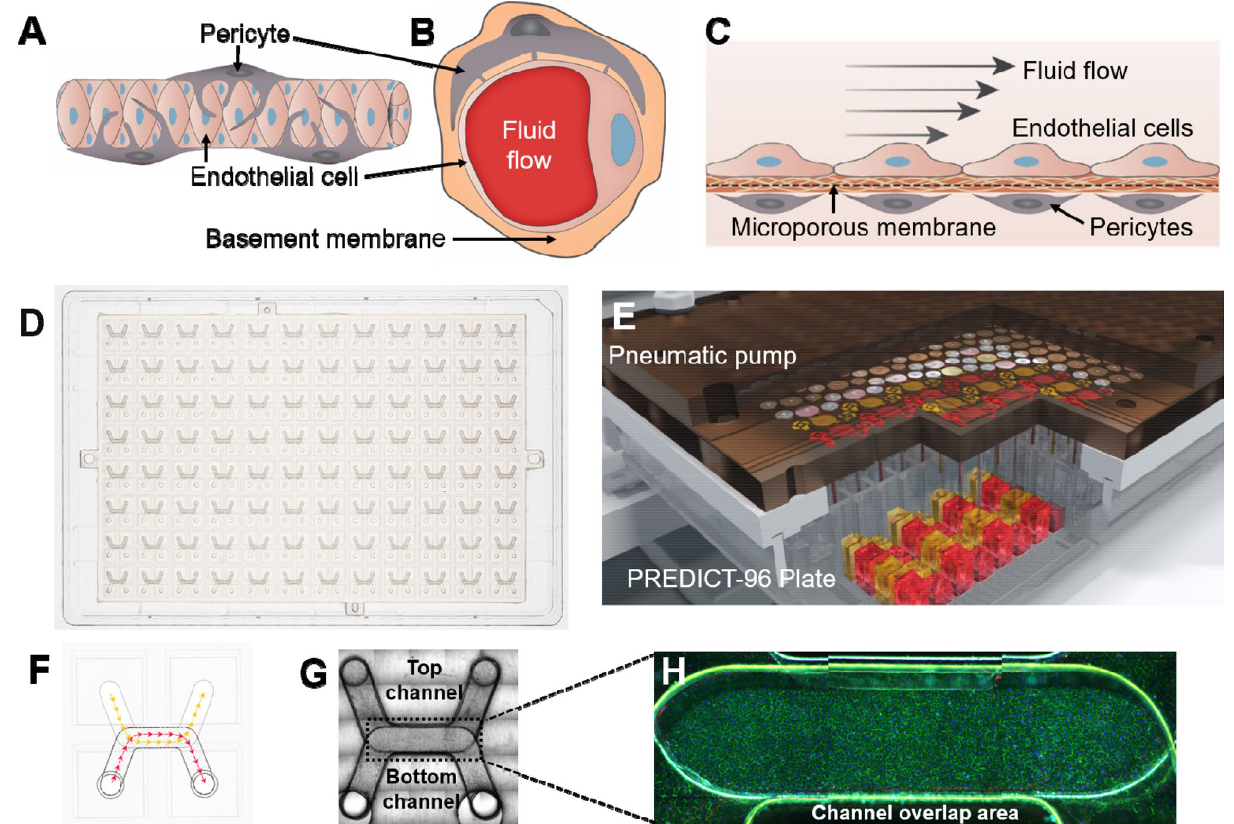
Figure 1. Development of the microfluidic microvascular co-culture model in the PREDICT96 platform. ( A ) Side-view schematic of the microvasculature. Capillaries are surrounded by pericytes which, under healthy conditions, help stabilize and mature the endothelium. ( B ) Cross-section schematic showing interaction of endothelial cells (ECs) and pericytes (PCs) through basement membrane. ( C ) Side-view cross-section schematic of the vascular model in the bilayer microfluidic device. ECs and PCs are cultured on either side of a microporous membrane coated with extracellular matrix, which allows interaction between the two cell types. ( D ) Top-view of the PREDICT96 plate, containing an array of 96 bilayer microfluidic devices that interfaces with a 384 well plate top. ( E ) Schematic of PREDICT96 custom pneumatic pump lid, containing 192 individual pumps that control fluid flow in each channel of the 96 bilayer devices. ( F ) A single PREDICT96 device corresponds to 4 wells of the 384 well plate with architecture allowing for culture and fluid flow in separate top and bottom channels, which overlap in the device center. ( G ) Top-view bright field image of a single device, with channel overlap area indicated as the region of interest (dotted rectangle). ( H ) Representative image of ECs stained for PECAM-1 (green) and Hoechst (blue) in channel overlap